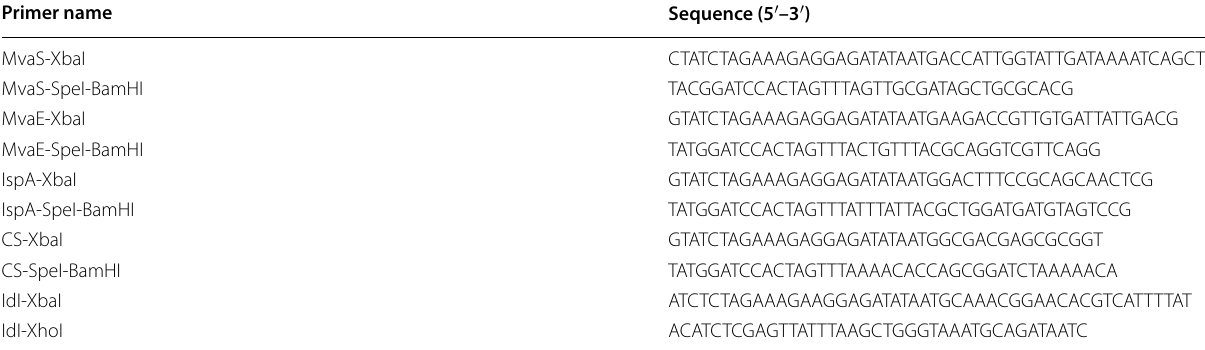
Table 1 Primers used in this study Primer name